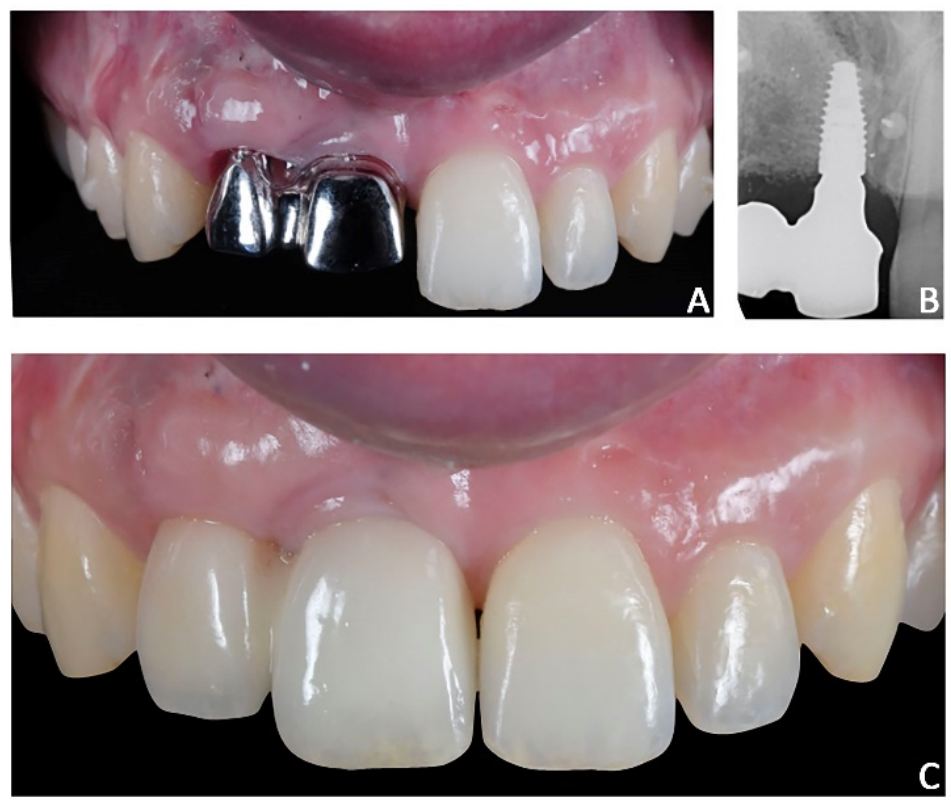
Figure 14. Case 2. Final prosthesis using milled cobalt-chrome structure and feldspathic porcelain. ( A ) Milled cobalt-chrome structure; ( B ) radiographic evaluation; ( C ) prosthesis veneered with feldspathic porcelain.